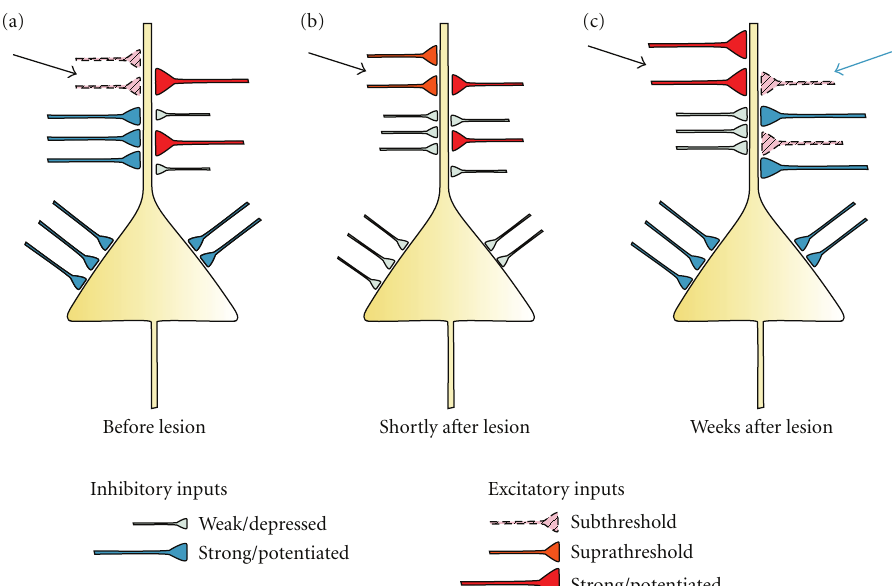
Figure 1: Schematic illustration representing a model pyramidal neuron in the cortex surrounding the lesion with its excitatory and inhibitory inputs before, shortly after and some weeks after the lesion occurrence. This model shows the potential cellular mechanisms responsible for the functional rewiring of neuronal networks following cortical injuries. (a) Before the occurrence of a cortical lesion, some excitatory inputs are subthreshold (arrow) being masked by strong inhibitory inputs; (b) early after the cortical lesion occurrence (first week postlesion), subthreshold connections can be converted into functional (suprathreshold) ones (arrow) by the lesion-induced weakening of inhibitory inputs; (c) some weeks after the lesion, experience-dependent plastic processes will likely lead to the reinforcement of some of the new functional inputs, which turn out to be behavioral relevant after the lesion (black arrow) and to the suppression of excitatory inputs which became irrelevant (blue arrow). For clarity, many cellular and subcellular elements have been omitted; this draw represents, therefore, an oversimplification of a real